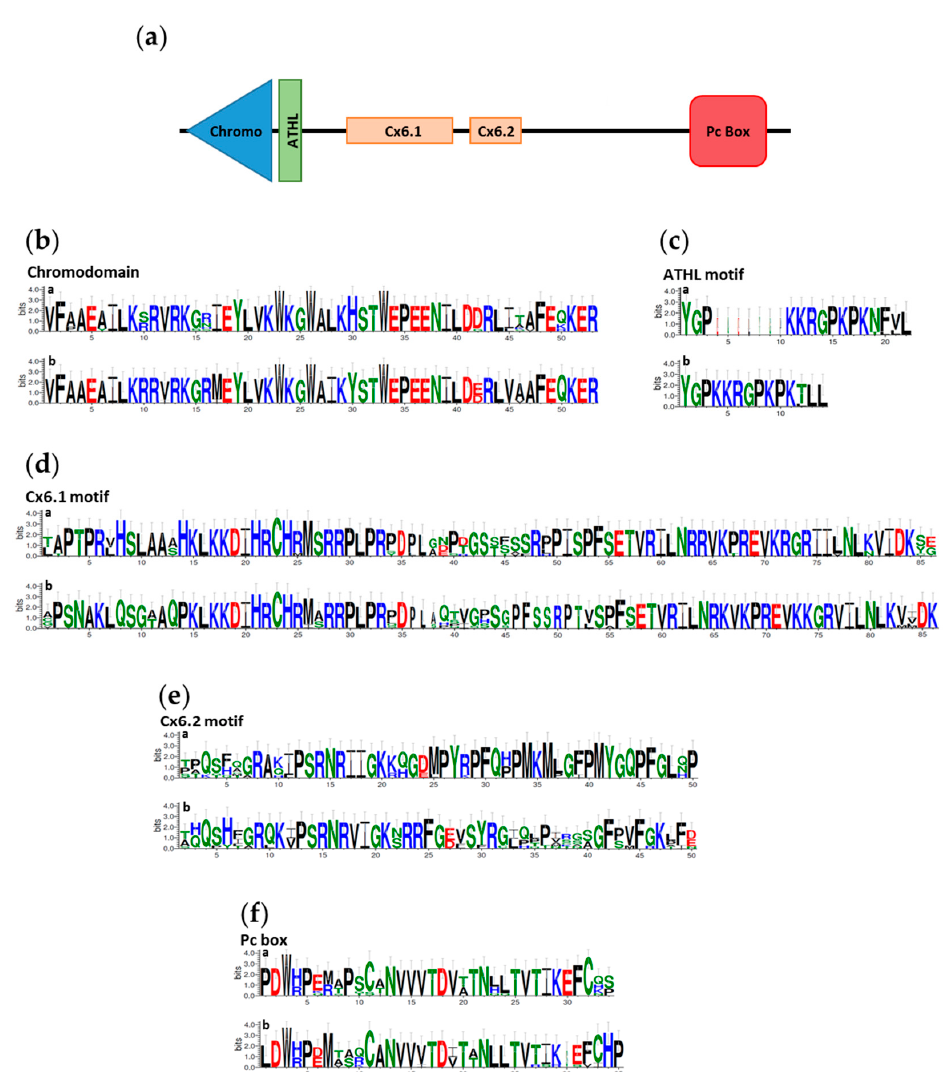
Figure 3. The Cbx6 conserved protein motifs. ( a ) Schematic representation of Cbx6 and its conserved regions. The sequences of the chromodomain ( b ), the ATHL ( c ), Cx6.1 ( d ), Cx6.2 ( e ) motifs and the Pc box ( f ) is shown for the Cbx6a (a: up) and Cbx6b (b: down) proteins. The height of amino acids is proportional to the frequency of occurrence (degree conservation) in each position and drawn in a logo format. Basic amino acids are in blue, hydrophobic in black, polar in green and acidic in red.